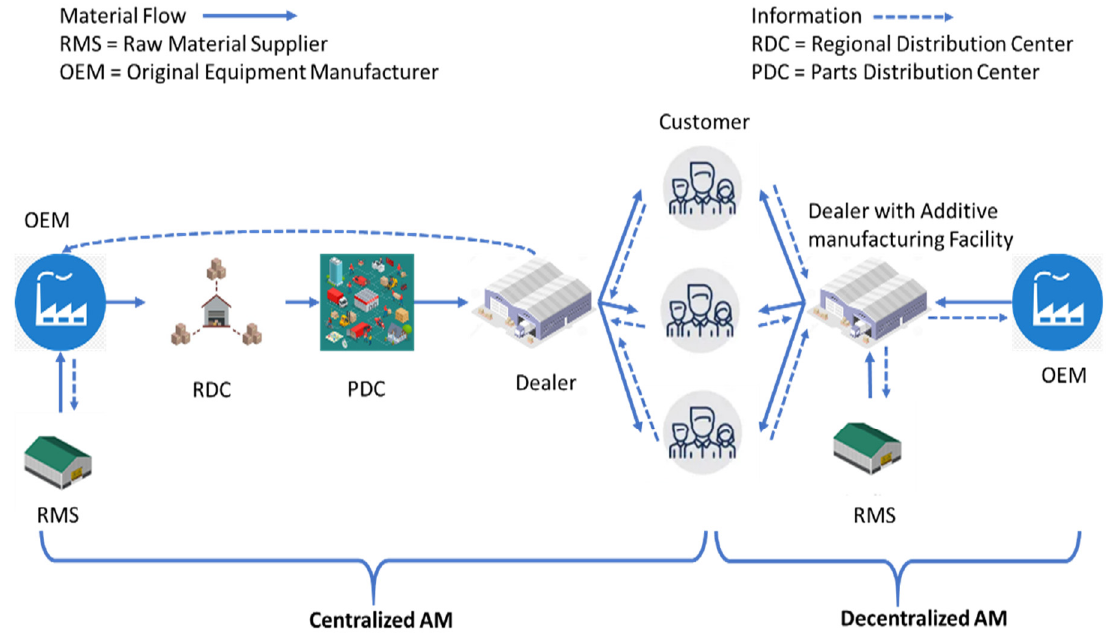
Figure 5. Illustration of Supply Chain Scenarios in Spare Parts Industry (Own illustration based on [114]). on